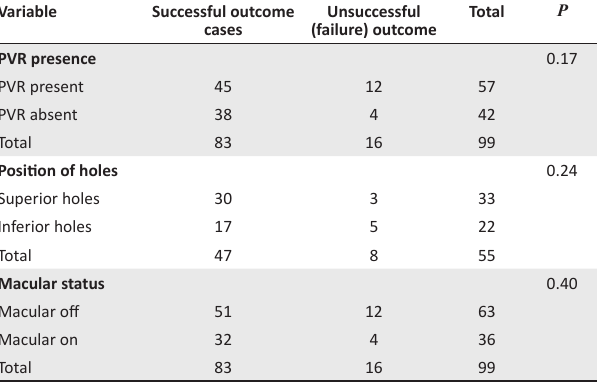
TABLE 2: Successful compared with unsuccessful surgical cases.